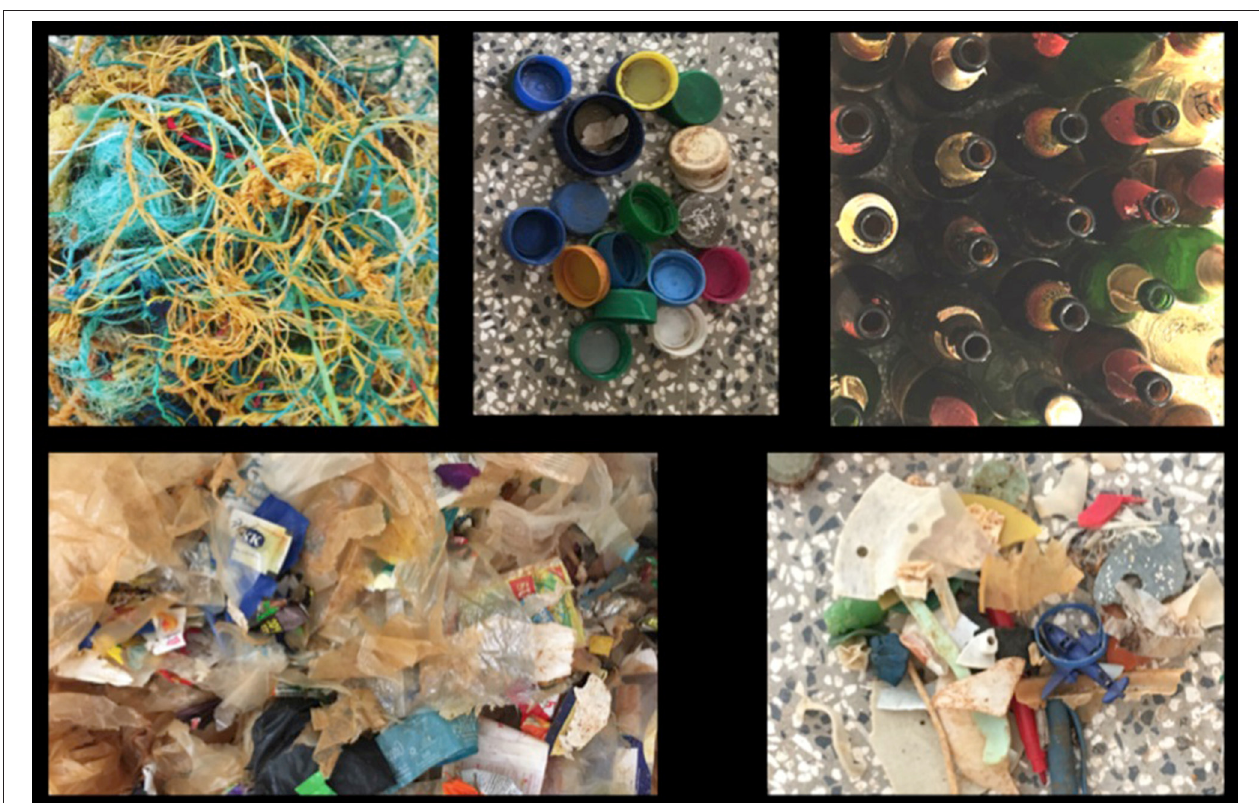
FIGURE 2 | Examples of some distinct categories including (clockwise from top left) nylon cords and ropes, plastic bottle caps, glass bottles, hard plastic fragments, filmed plastic fragments (Photos by K. Owens).